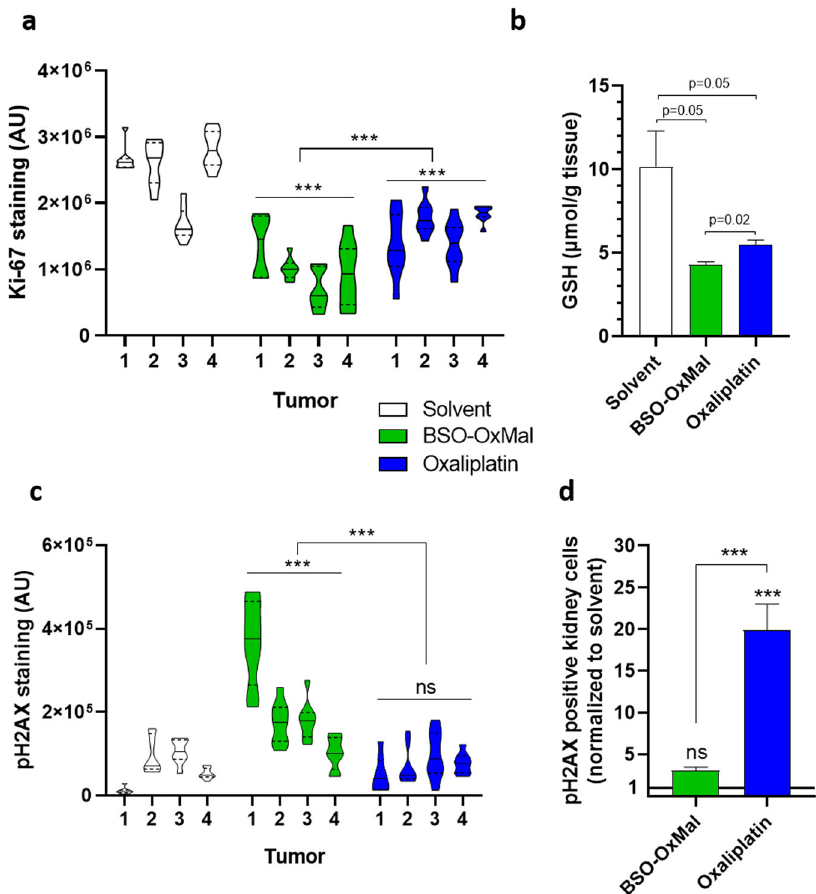
Fig. 9 Effects of BSO-OxMal and oxaliplatin treatment. Cancer proliferative activity ( a ) and GSH content ( b ) as well as DNA damage in tumor ( c ) and kidney ( d ) tissues. Mice bearing CT26 allografts ( n = 4 per group) were treated twice a week with equimolar concentrations of BSO-OxMal (23.5 mg/kg) or oxaliplatin (9 mg/kg) and sacri fi ced 24 h after the last drug dosing. Immunohistochemical staining of Ki-67 ( a ) and the DNA damage parameter pH2AX ( c ) were quanti fi ed in 8 – 10 regions of interest (ROI) per tumor within random non-necrotic, viable cancer regions by ImageJ software. In ( d ) cells stained positively for pH2AX in the kidney were counted within 5 ROI per kidney section. Representative images are shown for tumor sections in Supplementary Fig. 14 and for organ sections in Supplementary Fig. 15. In ( b ) tumor GSH content of the respective cancer samples was quanti fi ed by a calorimetric method as described in the methods section. Data in ( b , d ) are depicted as mean ± SEM (standard error of mean). Statistical signi fi cance was tested using one-way ANOVA ( a , c ) or Student´s t test ( b , d ). In all cases: * p < 0.05; ** p < 0.01; *** p <